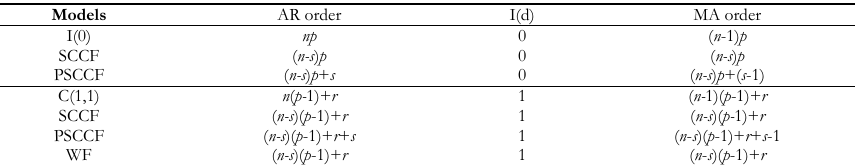
TABLE 3 Maximum ARIMA orders of univariate series generated by an n-dimensional VAR (p) with s cofeature